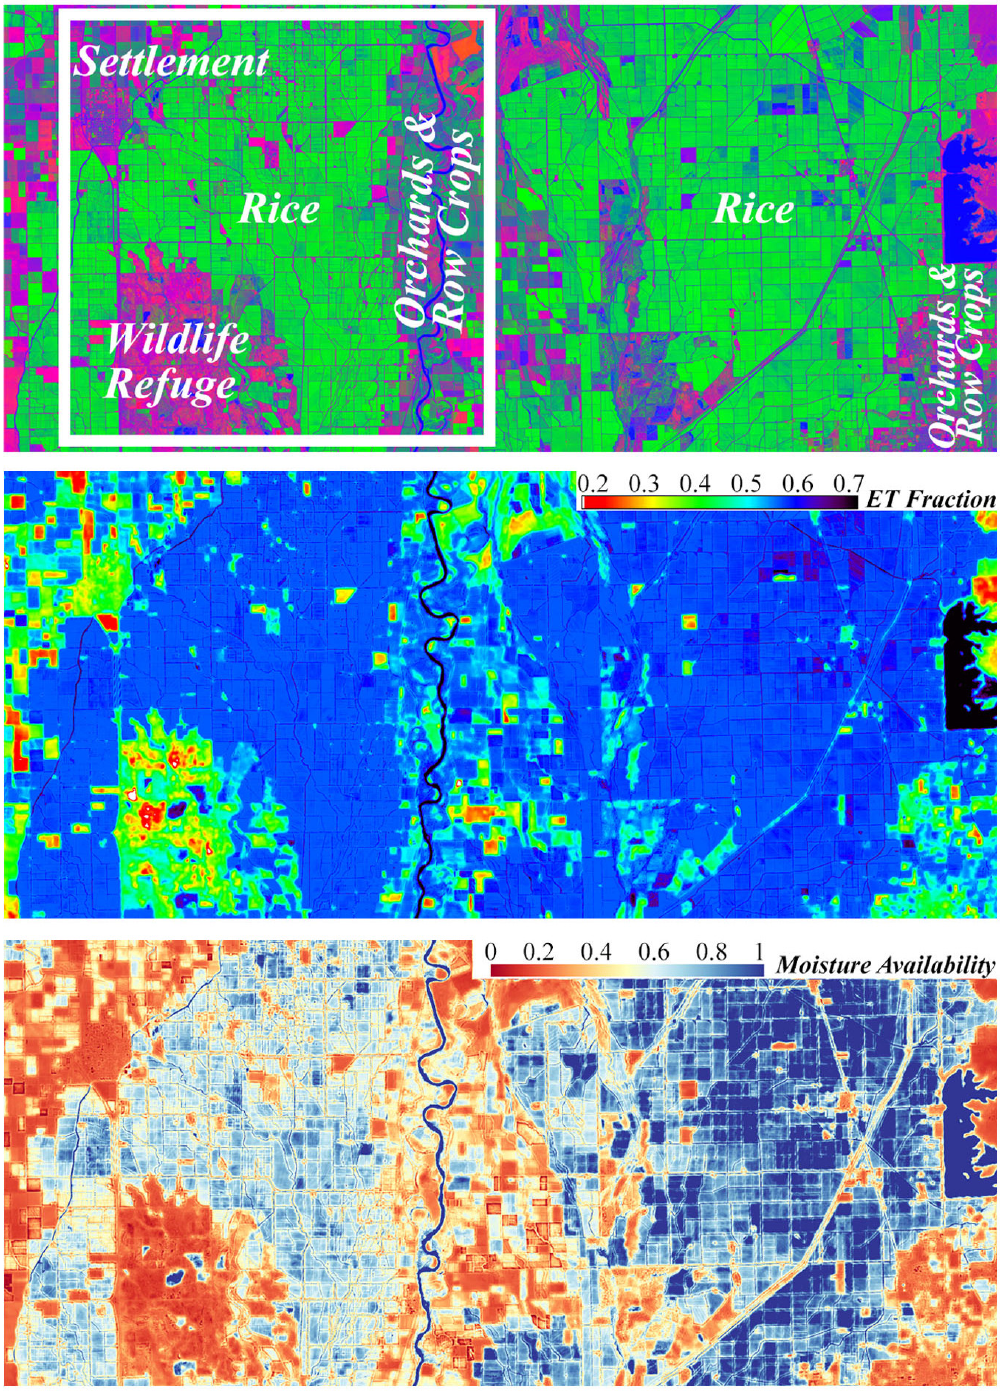
Figure 7. S, V & D fractions, along with EF & Mo, for a sample 15 × 50 km area imaged on August 14, 2016. Flooded paddies have high V and high Mo and EF. Fields in the western half of the image were planted earlier than in the east and have started to senesce, resulting in lower Mo. Orchards have low EF and Mo. The wildlife refuge is complex, with both high and low EF and Mo. Landsat 8 resolves heterogeneity both within individual fields as well as across the valley. The white box shows the spatial subset used for Figure 8.